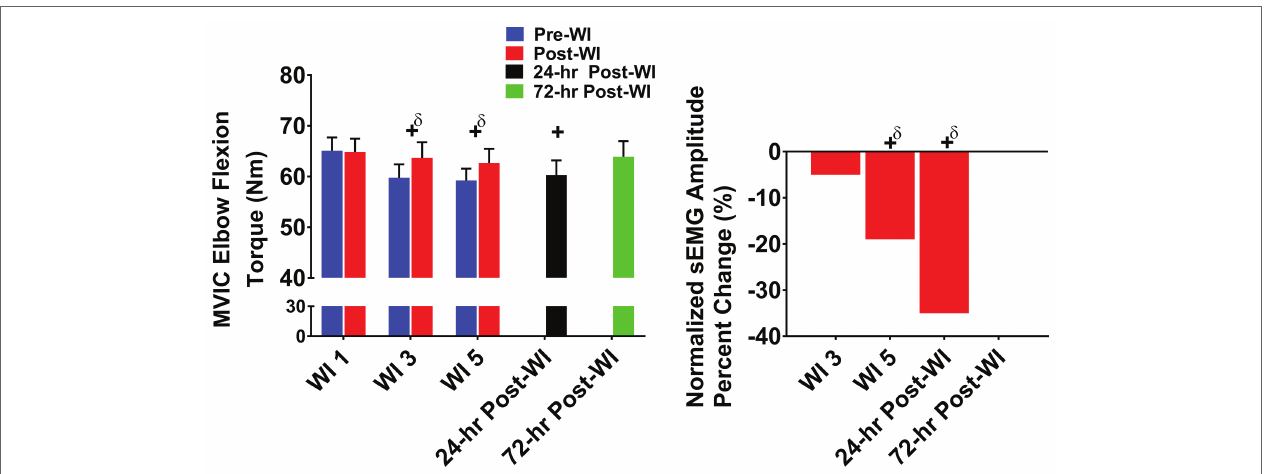
FIGURE 5 | MVIC elbow flexion results. Across subject ( n = 13) mean ± SEM is shown. Left graph – performance (force): overall performance declined throughout the entire dive week and did not recover until 72-h post-WI. “+” denotes time main effect ( p < 0.05). Main effect symbol with “ δ ” denotes ( p < 0.001). Right graph – Normalized sEMG day percent change: biceps brachii neuromuscular activation significantly declined throughout the dive week and on 24-h post-WI recovery period when compared to WI 1. “+” denotes time main effect ( p < 0.05). Main effect symbol with “ δ ” denotes ( p < 0.001).